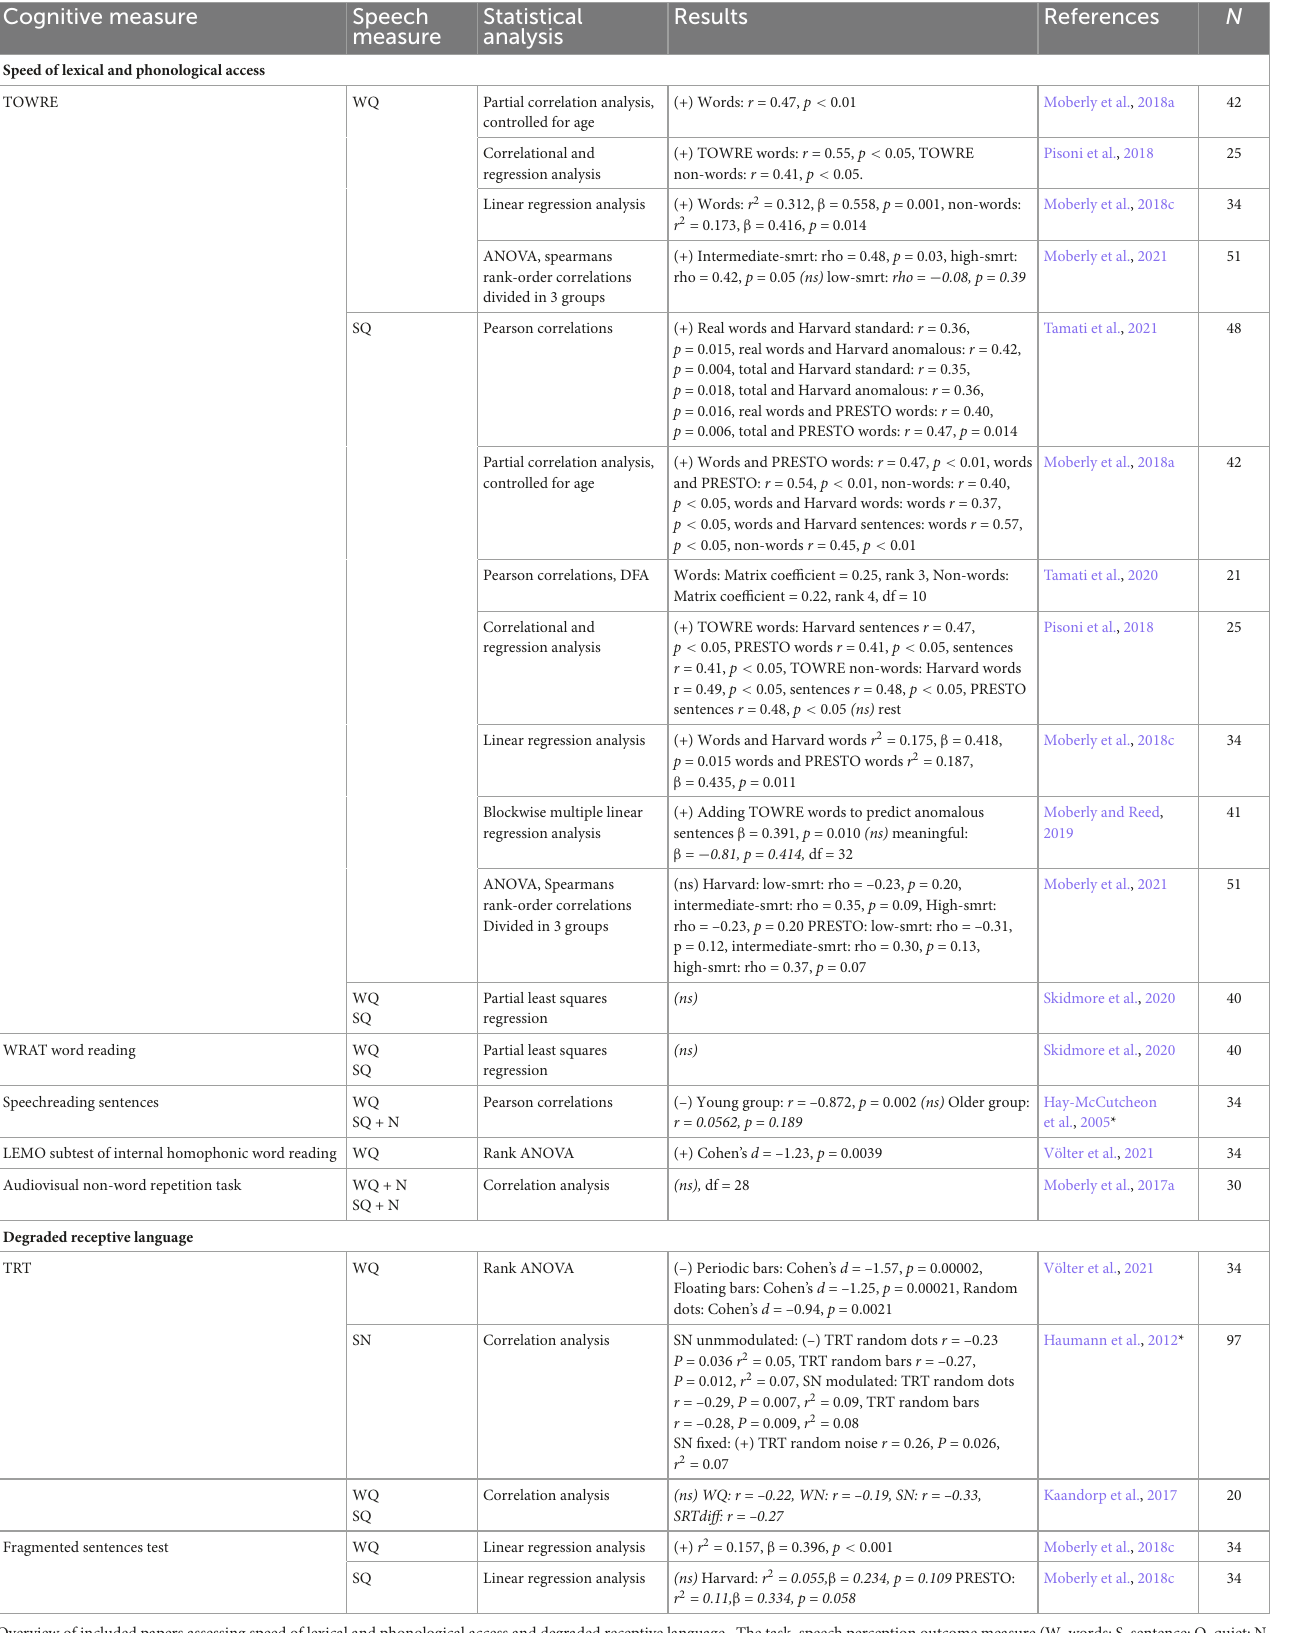
Overviewofincludedpapersassessingspeedoflexicalandphonologicalaccessanddegradedreceptivelanguage.Thetask,speechperceptionoutcomemeasure(W,words;S,sentence;Q,quiet;N, noise),statisticalanalysis(includingareportofapoweranalysis(y),yes;(n),no;df,degreesoffreedom),keyfinding[(+),positivesignificantresult,(–),negativesignificantresult;